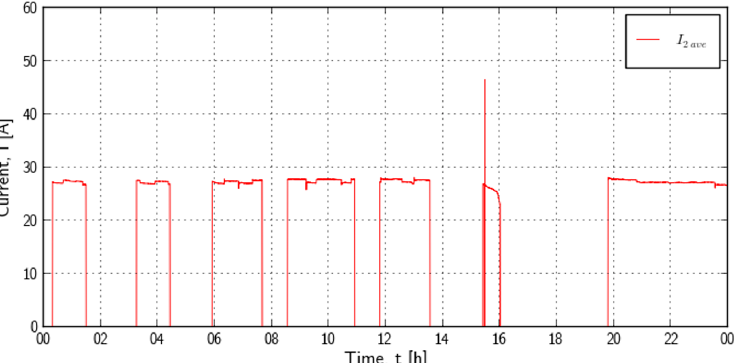
Figure 30. The simulation of the PU2 load current average values obtained by the application of the extended hybrid model.